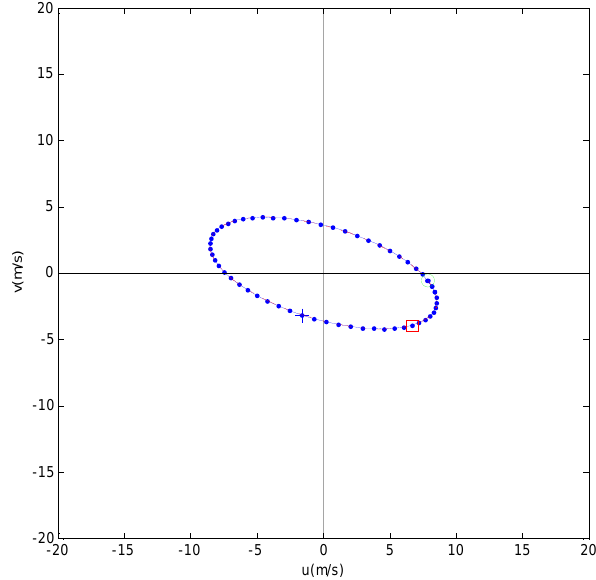
Fig. 2a. Hodograph analysis of vertical profiles of three wind com- Fig.2a Hodograph analysis of vertical profiles of three wind components and the horizontal velocity 5 ponents and the horizontal velocity amplitude induced by the su- amplitude induced by the superposition of two waves characterized by Table 1a with 0.5 α = in perposition of two waves characterised by Table 1a with α = 0 . 5 in equations (8a, 8b, 8c) at the 85 th time step. The rotation sense of this hodograph is clockwise (from Eqs. (8a), (8b), (8c) at the 85th time step. The rotation sense of this green circle to red square to blue cross). hodograph is clockwise (from a green circle to a red square to a blue cross). τ = 8 . 25h and φ az = 106 . 6 ◦ were obtained by this analysis. analysis.